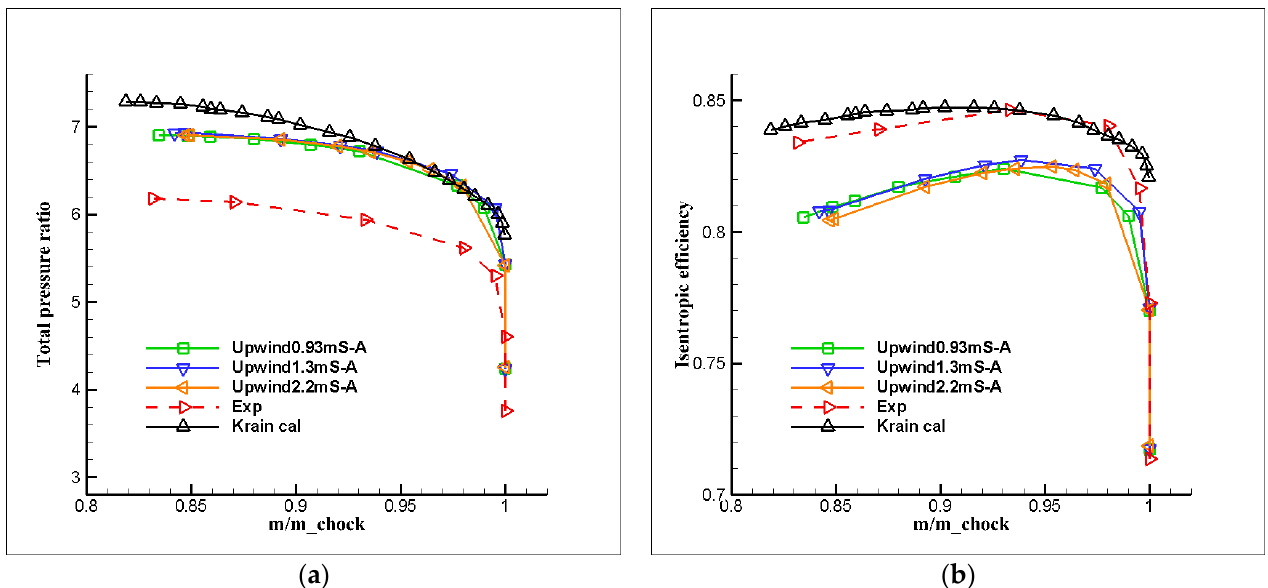
Figure 7. Compressor performance under different grid numbers. ( a ) Total pressure ratio. ( b ) Isentropic efficiency.